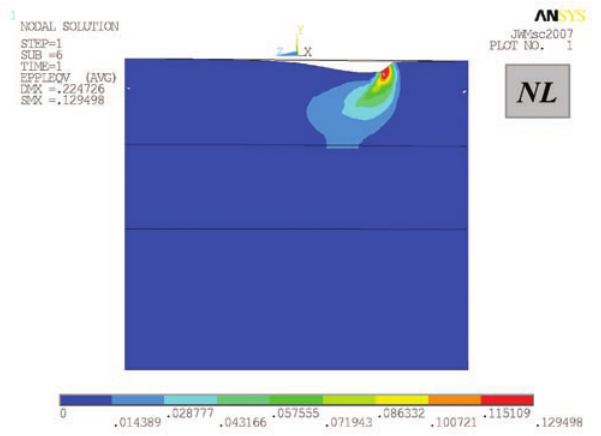
Fig. 14. Distribution of plastic shear strains according to von Mises criterion in the soil f H-M , NL ( ε ) ∈ [0; 0.129], m/m